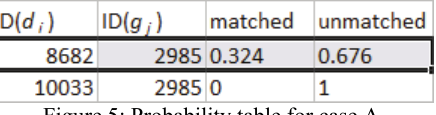
Figure 5: Probability table for case A